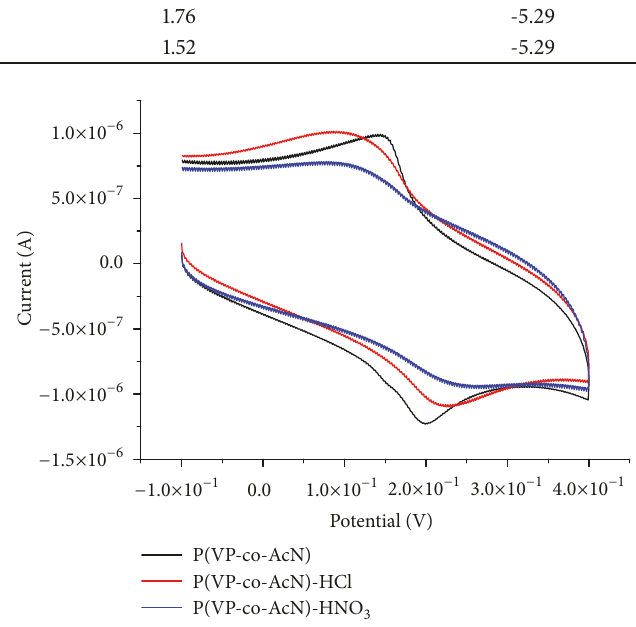
Figure 6: Cyclic voltammogram of copolymer and the polyelectrolytes.